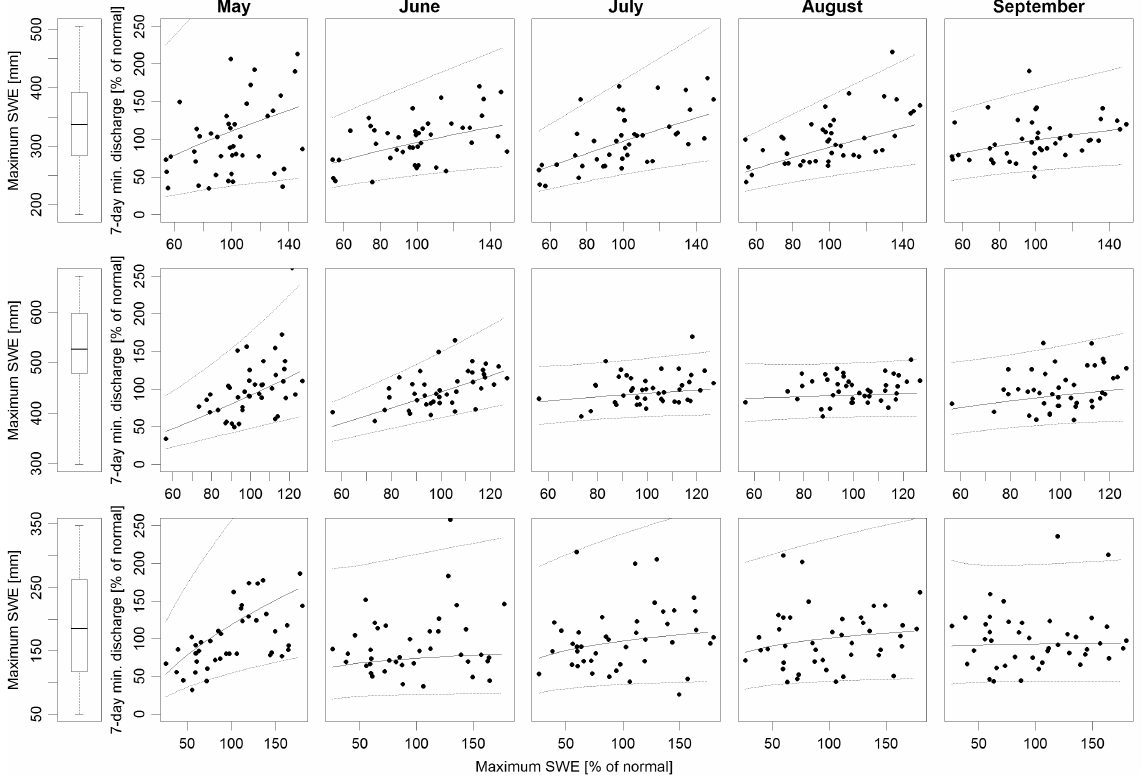
Figure 3. Dependence of 7-day minimum discharge on maximum SWE for individual months. Top panels: Ova da Cluozza River representing a high-elevation catchment with a mean catchment elevation of 2361ma.s.l., correlations from May to September are statistically significant (0.05 level). Middle panels: Simme River, representing a middle-elevation catchment with a mean catchment elevation of 1632ma.s.l., correlations from May to June are significant. Bottom panels: Sitter River as a representative of a low-elevation catchment with a mean catchment elevation of 1247ma.s.l., only the correlation in May is significant. Solid lines represent the low flow occurring with a 50% probability, dotted lines represent the 95% prediction interval. The boxes represent the 25 and 75% quantiles, with the thick line showing the median, and the whiskers represent minimum and maximum